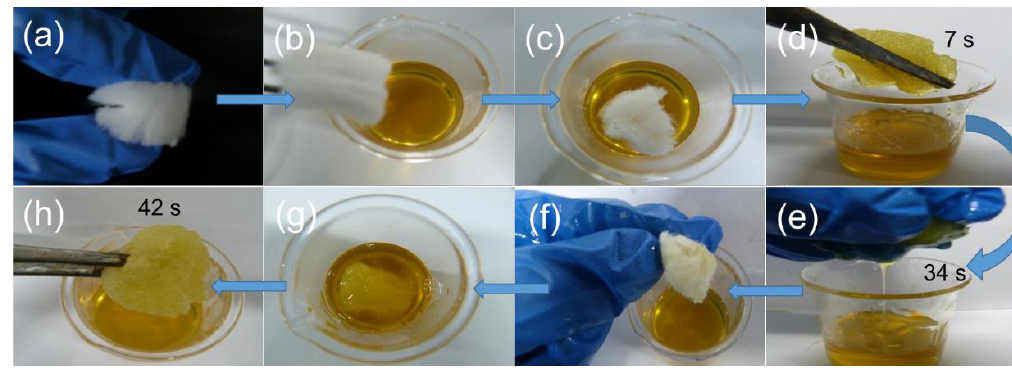
Figure 8. Pump oil recovery and reuse of CF 3:2 .